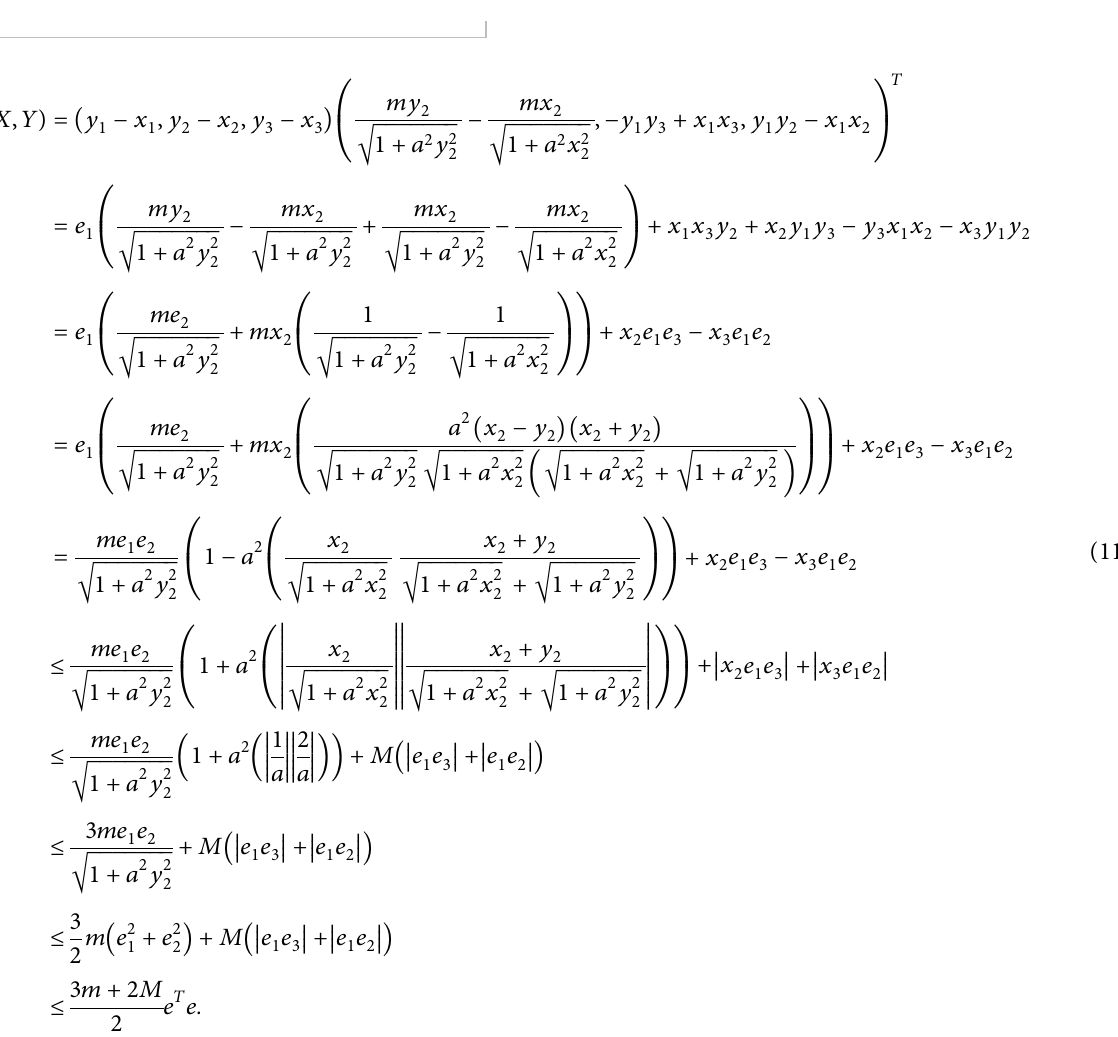
Figure 4: The chaotic phenomenon of system (3) with the initial condition ( x series of x i , i � 1, 2,